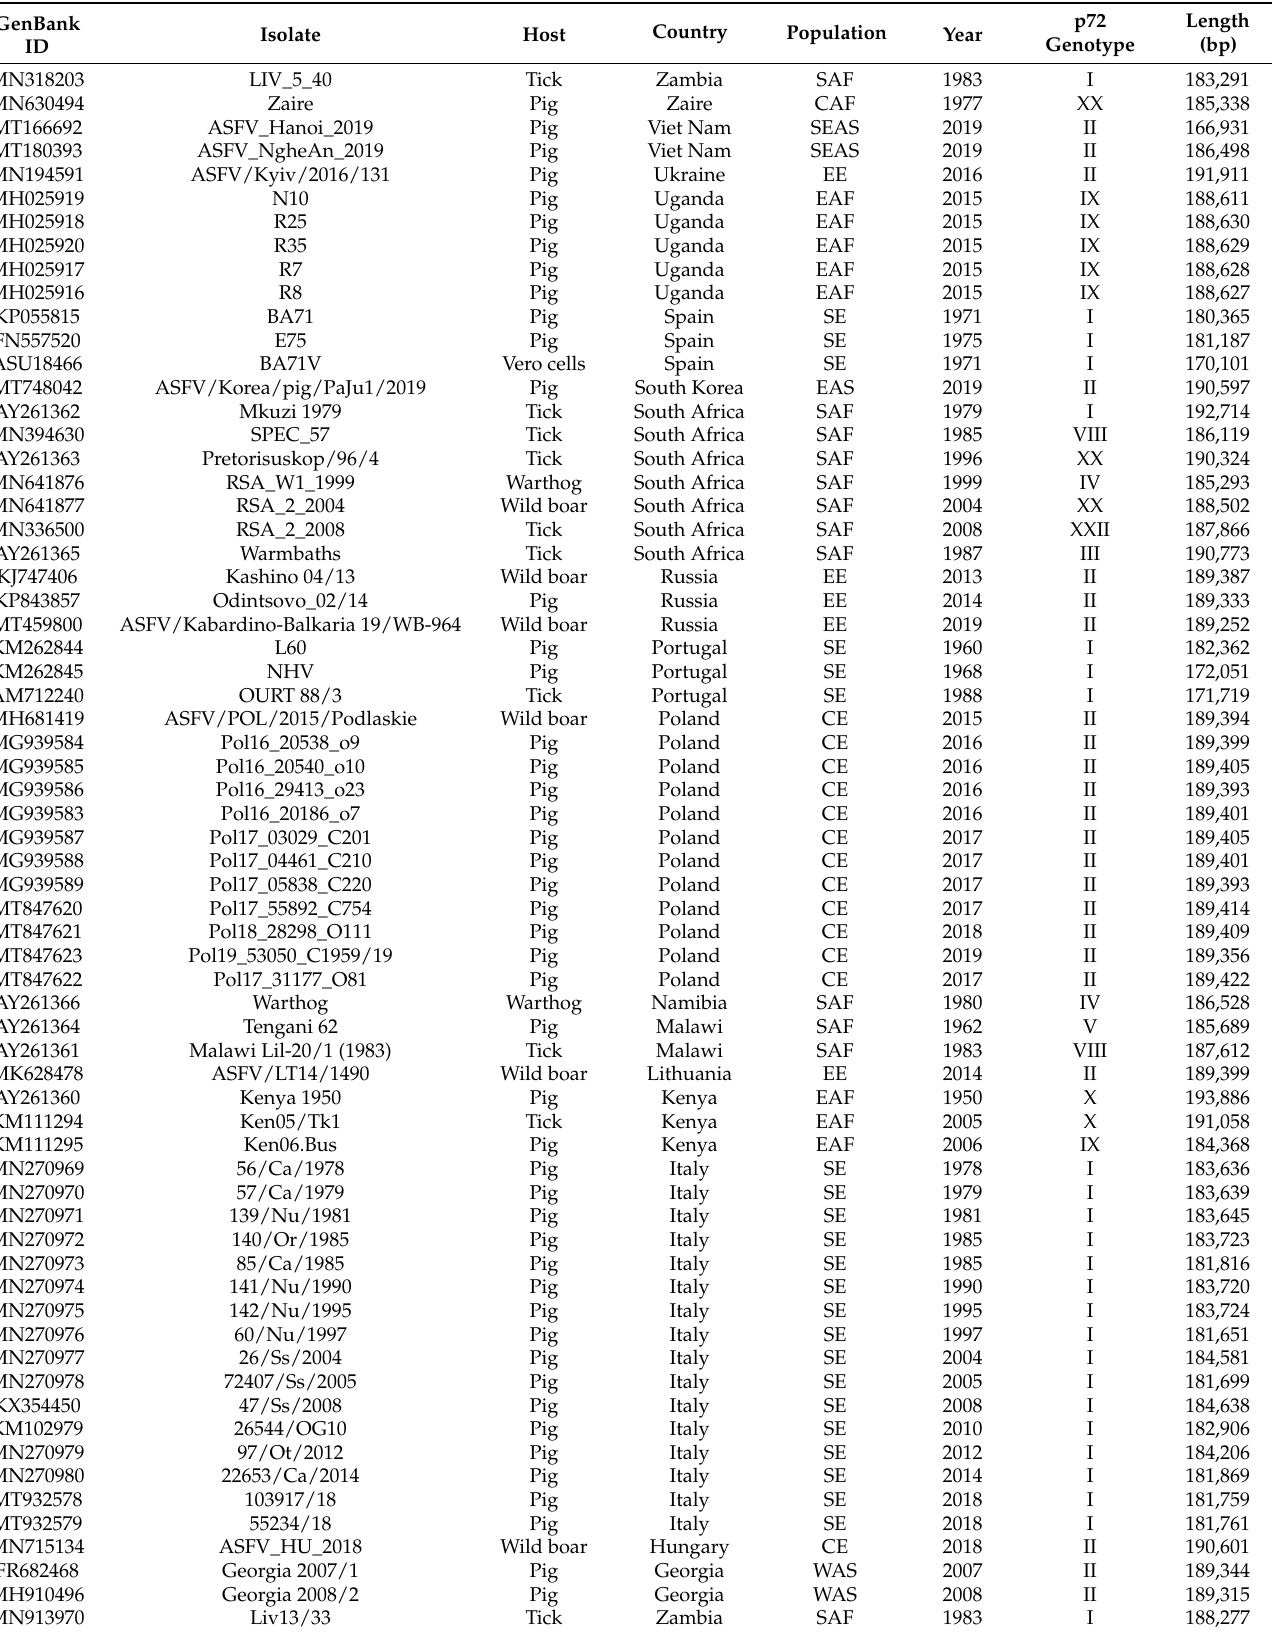
Table 1. ASFV isolates used in this